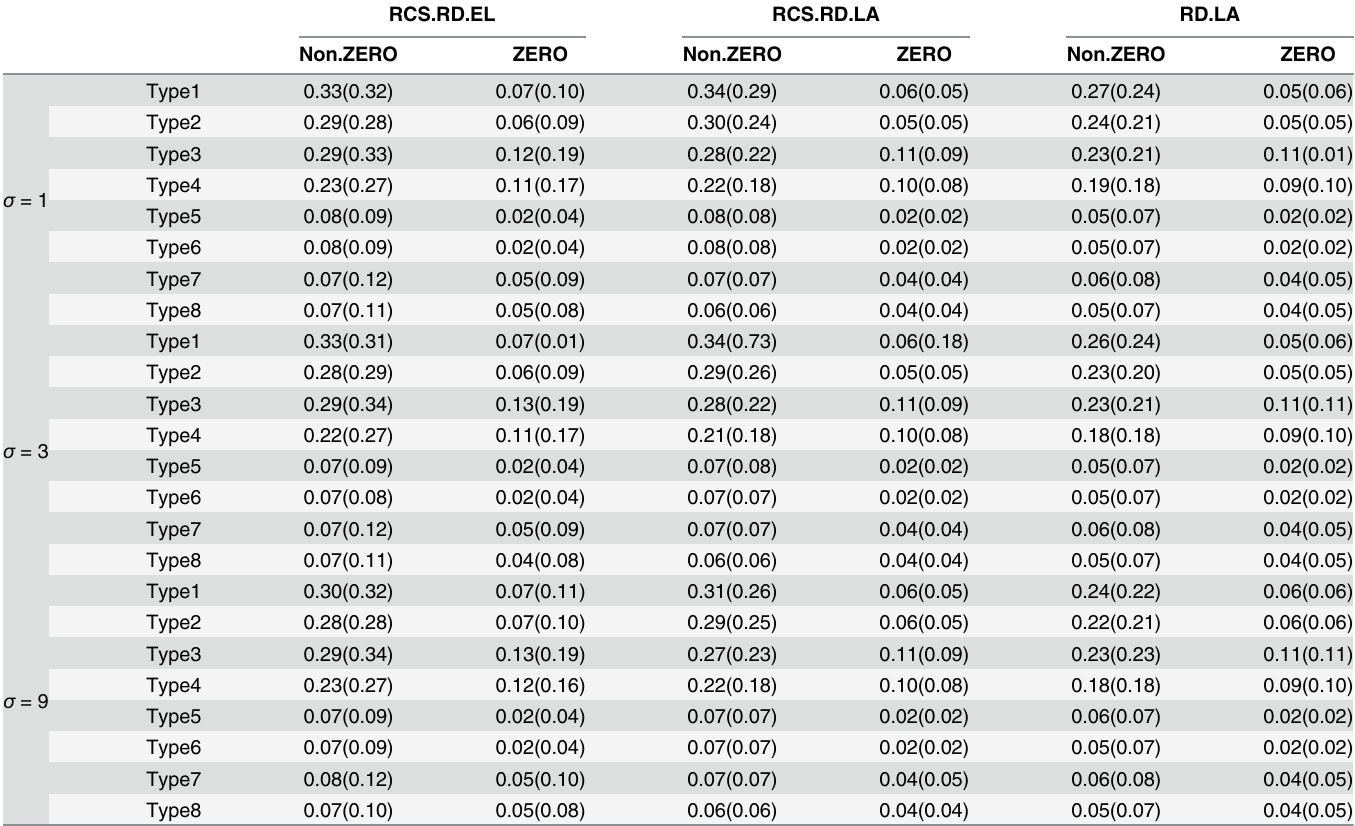
Table 2. Average of importance measures for predictor variables with non-zero and zero